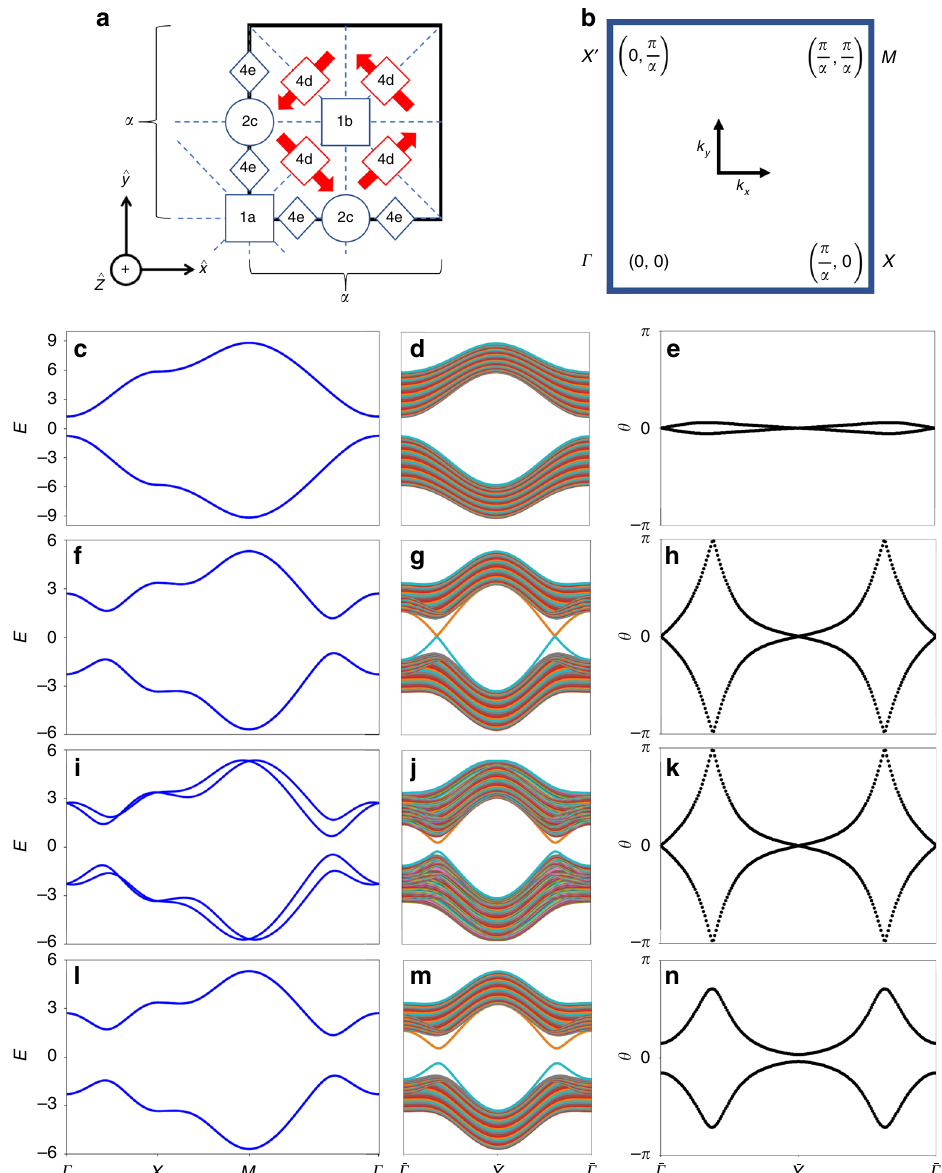
Fig. 2 TCI, fragile, and QI phases in 2D insulators with p 4 m symmetry. a T -symmetric layer group p 4 = mmm 1 0 reduces to type-III magnetic layer group 62 p 4 = m 0 mm under the application of a magnetic potential with no net magnetic moment in each unit cell (Supplementary Note 3); this can be achieved by placing spin-1 ∕ 2 magnetic moments (red arrows in a ) at the 4 d Wyckoff position with orientations related by C 4 z and M x , y . b BZ and c bulk bands for a model (Eq. (1)) that respects p 4 = mmm 1 0 (Table 1), which has M z and T symmetries, as well as the symmetries of p 4 = m 0 mm in a ; this model is constructed from s and d x 2 (cid:3) y 2 orbitals at the 1 a Wyckoff position. Eq. (1) can be tuned between a trivial and a mirror TCI phase ( f ), distinguished by their ( d , g ) ribbon edge spectra and ( e , h ) x -directed Wilson loops plotted as functions of k y (Eq. (2)). i Relaxing M z while preserving C 2 z and T by introducing Eq. (3) to Eq. (1), ( k ) we realize a four-band model with the same Wilson loop winding as the 2D TCI phase in f – h , but ( j ) without topological edge states. The Wilson loop in k can either be trivialized by the addition of more orbitals to the model (Supplementary Note 4), or gapped by the magnetic potential depicted in a . l Upon gapping ( m ) the surface and ( n ) Wilson bands with magnetism that breaks M z while preserving magnetic wallpaper group 28,62 p 4 m , which we accomplish by adding the potential in Eq. (4), the Wannier centers of the topological phases in f – k localize at the 1 b position (Supplementary Note 3), realizing an insulator topologically equivalent to the QI introduced in ref. 23 (Supplementary Note